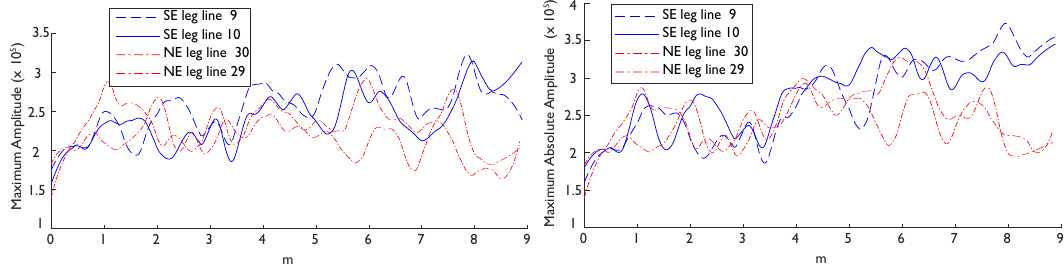
Figure 6. Reflection attributes: maximum amplitude ( left ) and maximum absolute amplitude ( right ) for two representative transects in the center of the deck, showing increased values for the southeast (SE) leg (blue solid and large dash) to the right side of the connection between the two construction